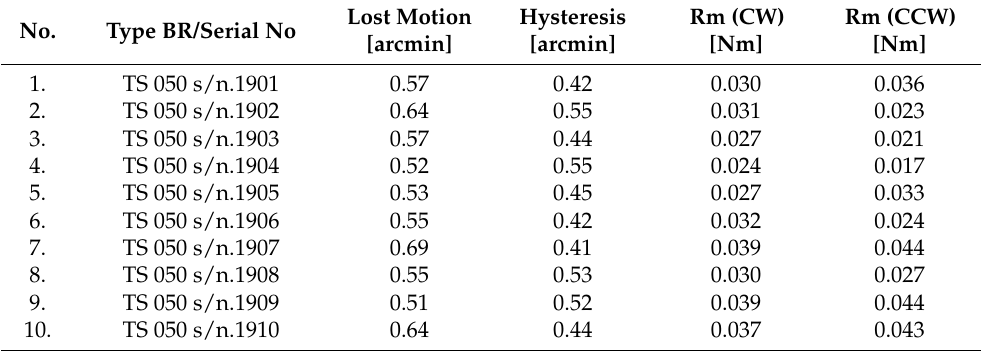
Table 2. Bearing reducer TS 050 parameters measured before the trial run (configuration A). No.